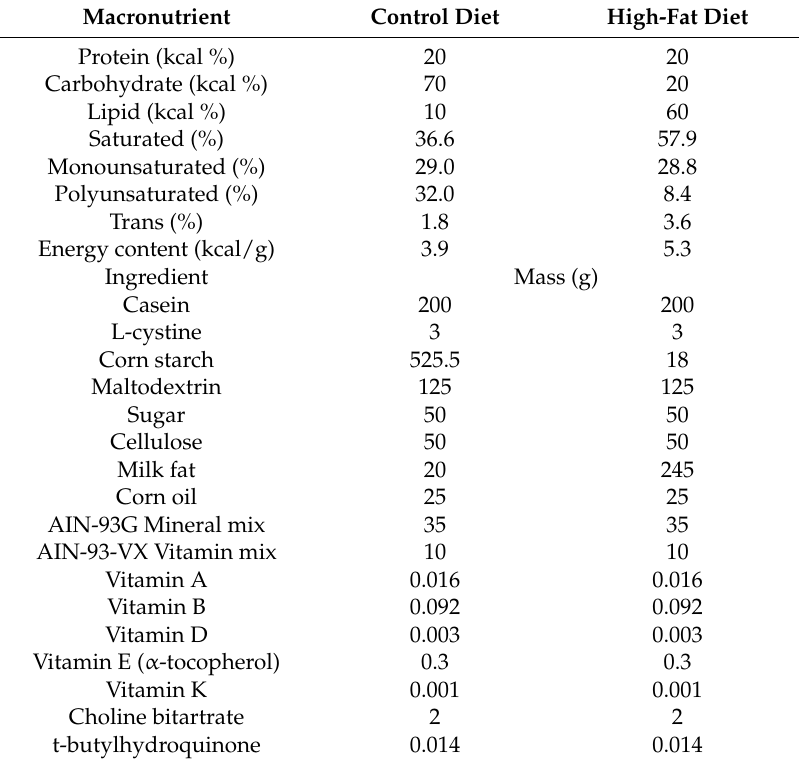
Table 1. Macronutrient composition and ingredients of control and high-fat diets.